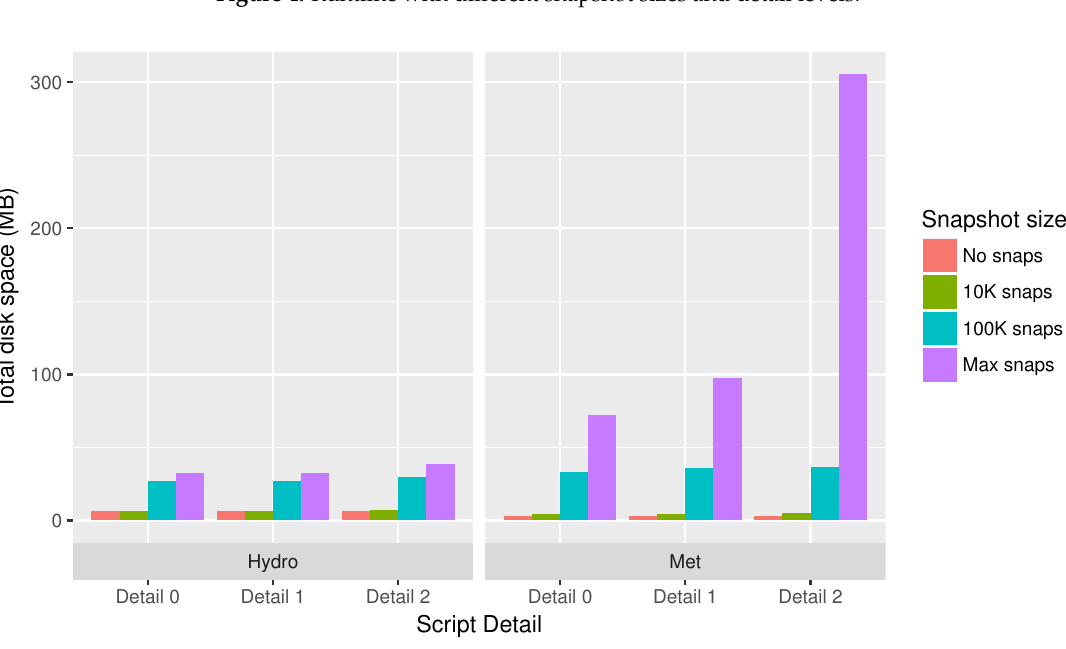
Figure 4. Runtime with different snapshot sizes and detail levels.